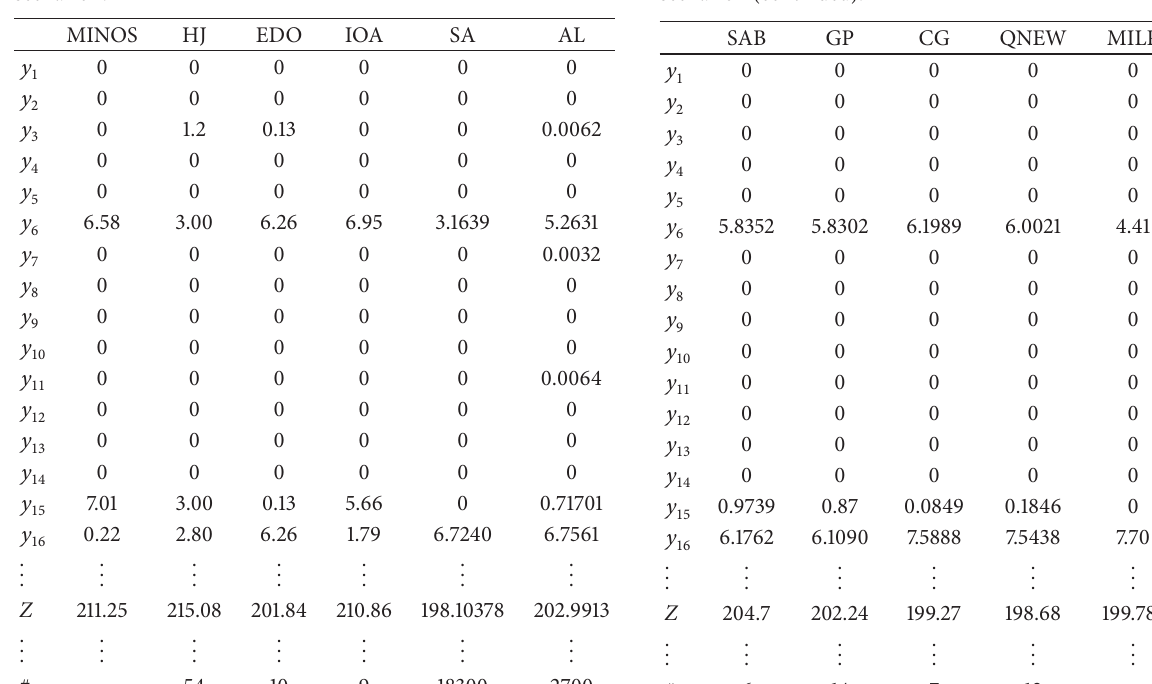
Table 3: Comparison of results from solving the 16-link network for scenario 1.